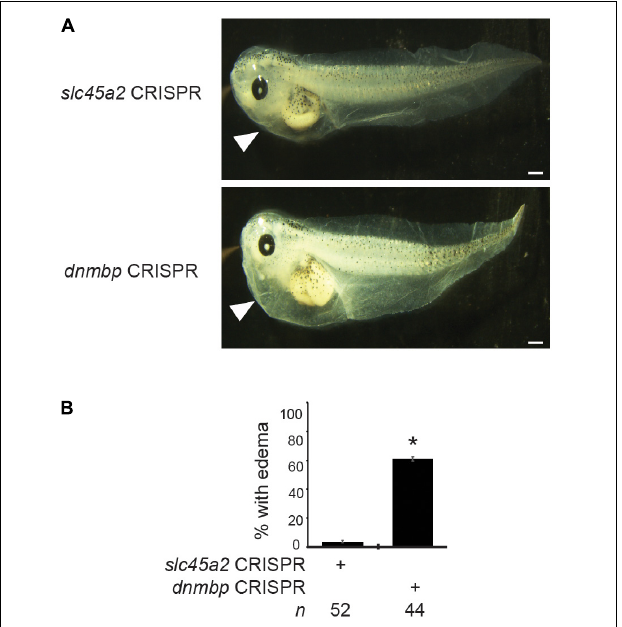
FIGURE 11 | dnmbp CRISPR knockout results in edema formation. (A) Bilateral injection of dnmbp sgRNA and Cas9 protein into both ventral blastomeres at the 4-cell stage leads to edema formation in comparison to embryos injected with slc45a2 sgRNA and Cas9 protein. Representative stage 45–46 embryos shown. White arrowhead indicates area of fluid accumulation. Scale bar indicates 500 µ m. (B) Percent of embryos exhibiting edema formation. n = number of embryos across 3 replications. Error bars represent Standard error. ∗ Significantly different from control, p <